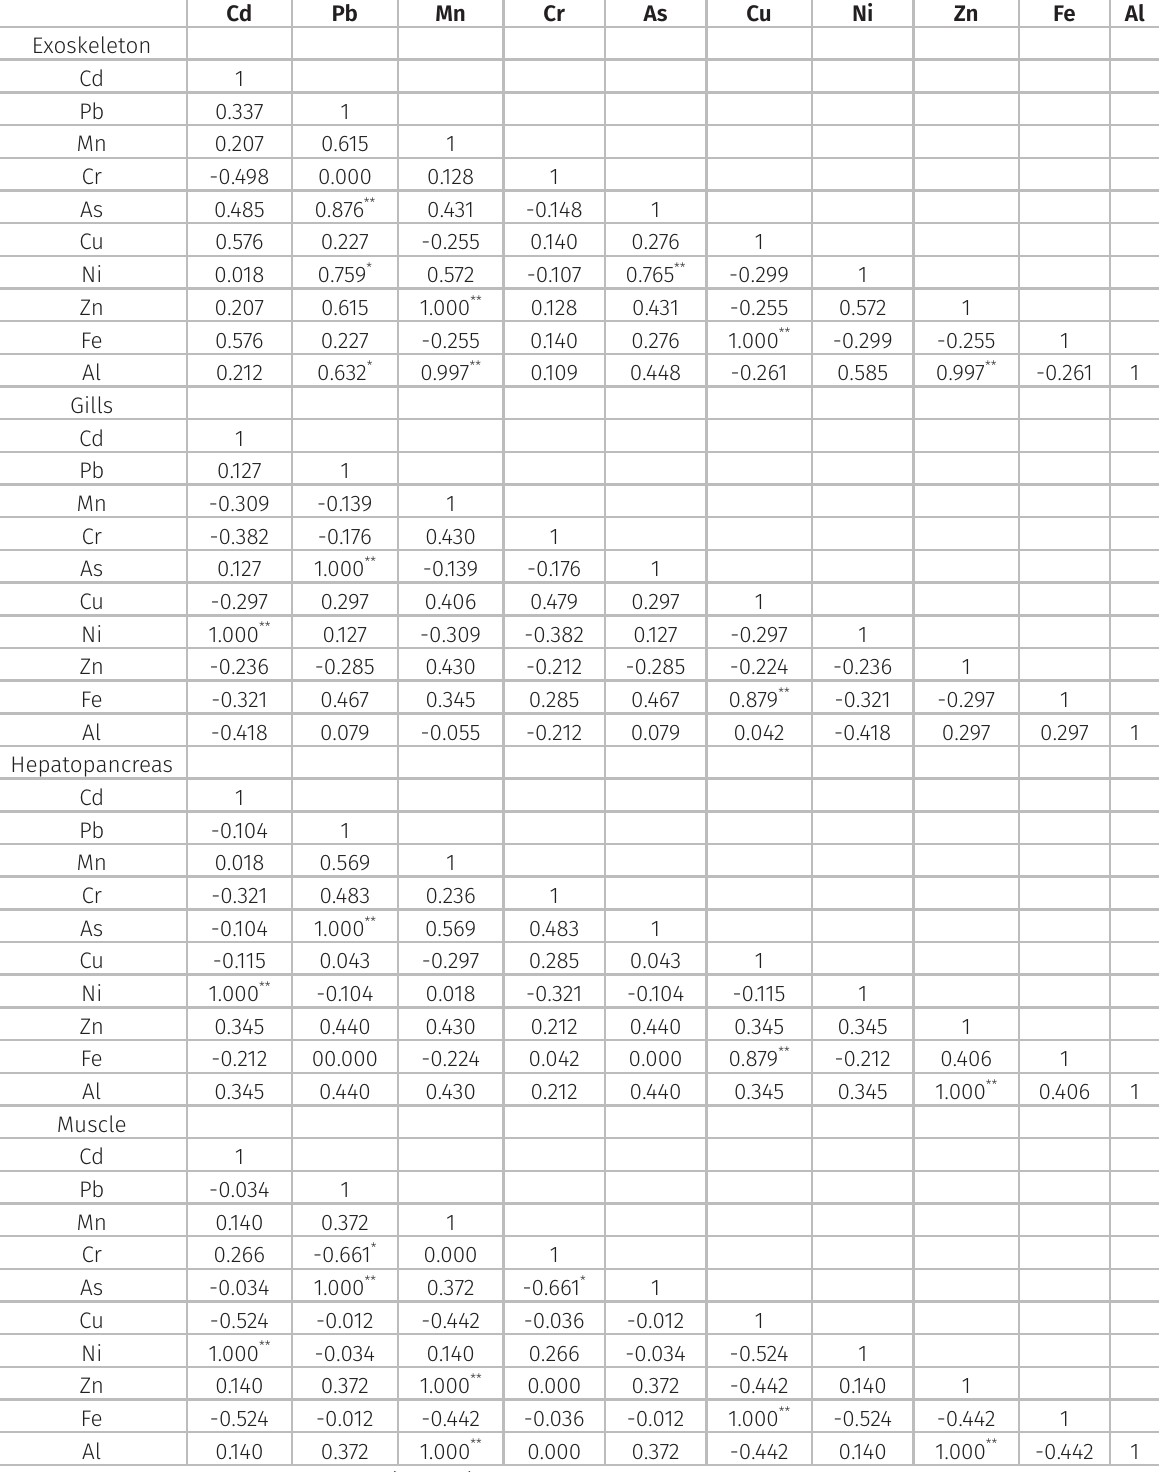
Table II. Correlations between metal concentrations in the tissues of P.